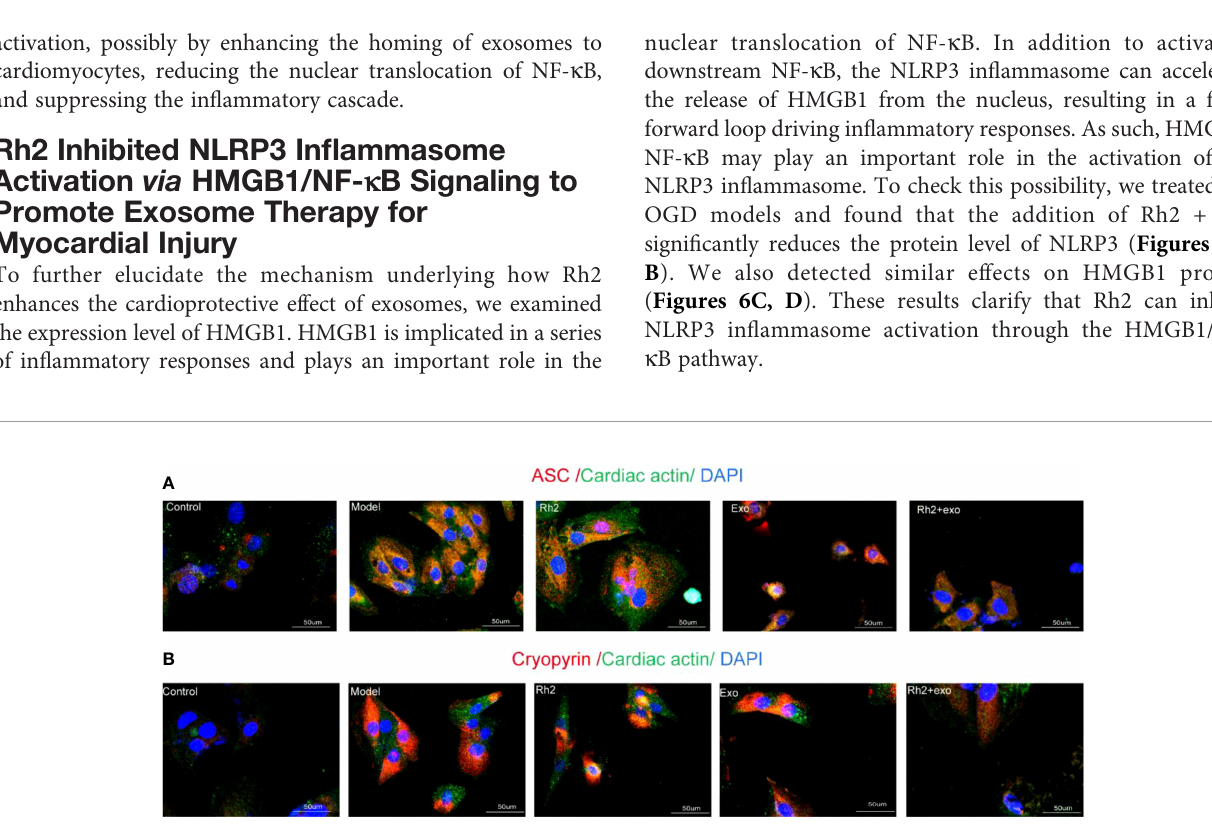
FIGURE 5 | Ginsenoside Rh2 enhanced exosome inhibition of different components of NLRP3 in fl ammasome activation. (A, B) The protein expression levels of the ASC (red color) and Cryopyrin (red color) in H9c2 by immuno fl uorescence, and the slides were counterstained with DAPI (blue).